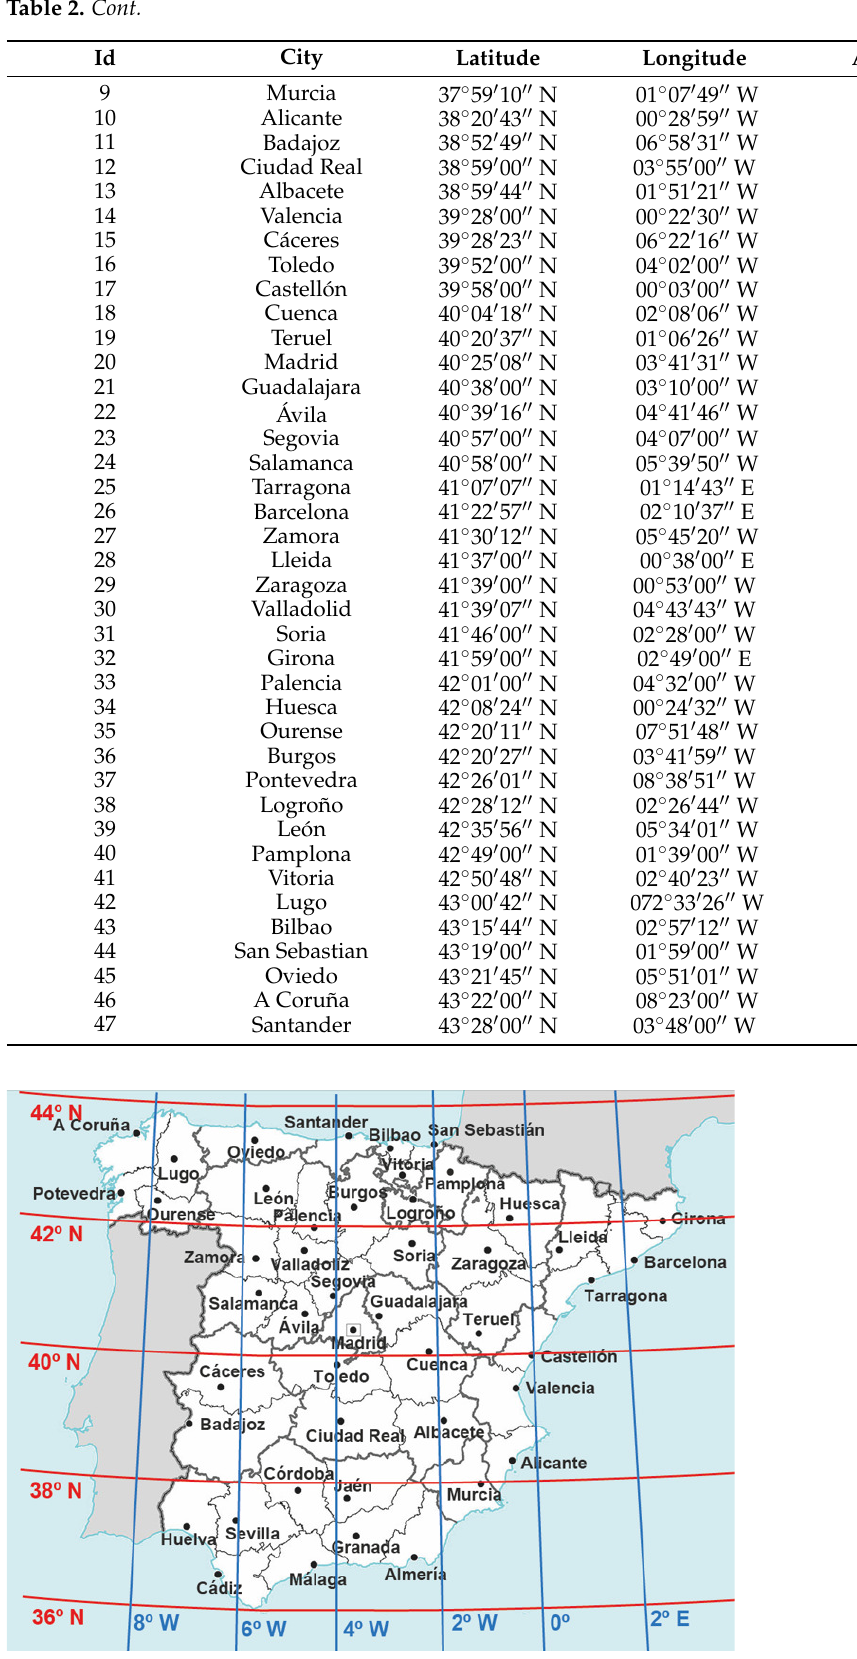
Figure 1. Map showing locations of cities